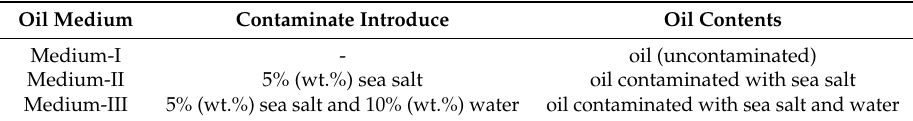
Table 4. Oil mediums and the contaminants used for tribo-corrosion